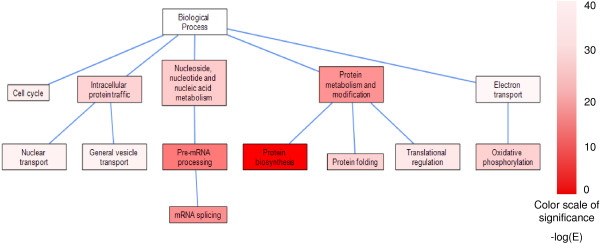
Biological processes enriched in housekeeping genes. Enriched biological processes (E value < 0.05) and their ancestors from the Panther Ontology are shown in a hierarchical structure. E values were calculated by hypergeometric distribution with a Bonferroni correction. The intensity of color is proportional to the significance of gene enrichment (-log(E value), ranging from the lightest 2.3 to the darkest 39.1).